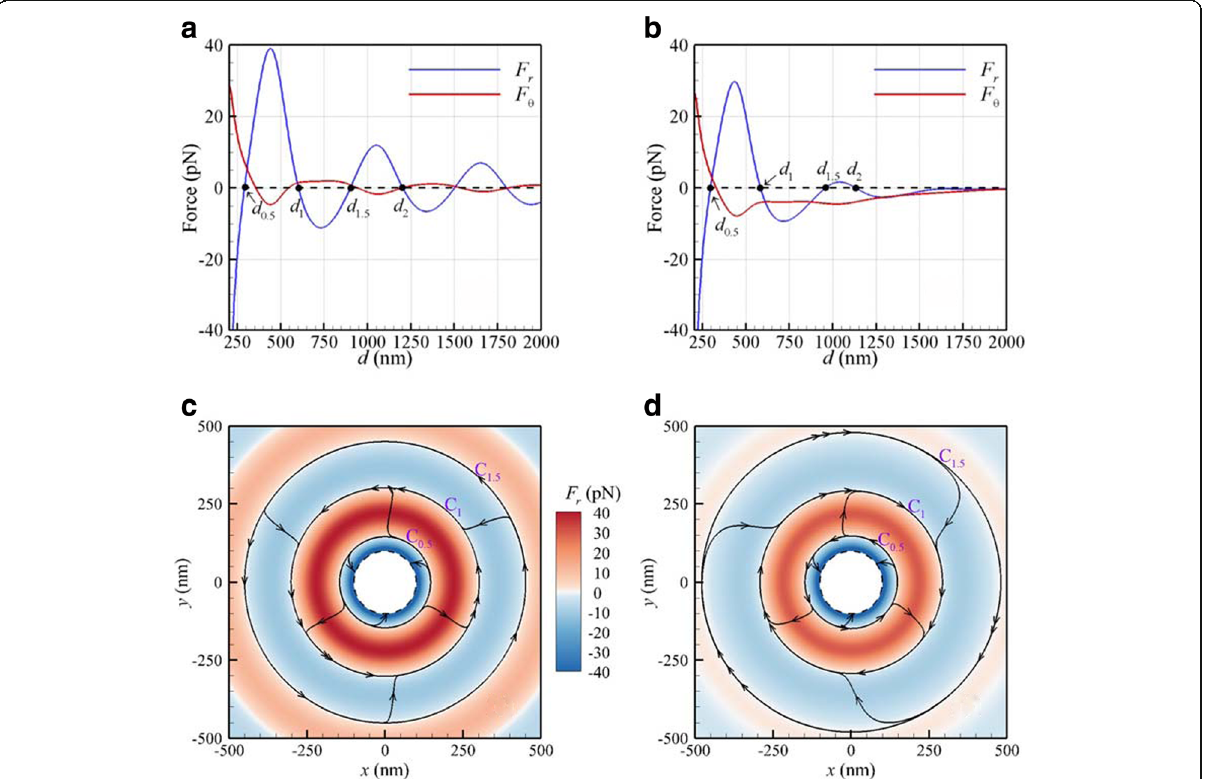
Fig. 2 Optical forces ( F r , F θ ) versus d for λ = 800 nm by CP a plane wave and b Gaussian beam with a waist of 500 nm at the focal plane. The 2D streamline maps of optical force ( F r , F θ ) induced by CP c plane wave and d Gaussian beam. The color bar represents the amplitude of F r . The dashed ring is the limit circle of the centers of two NPs where NPs are in